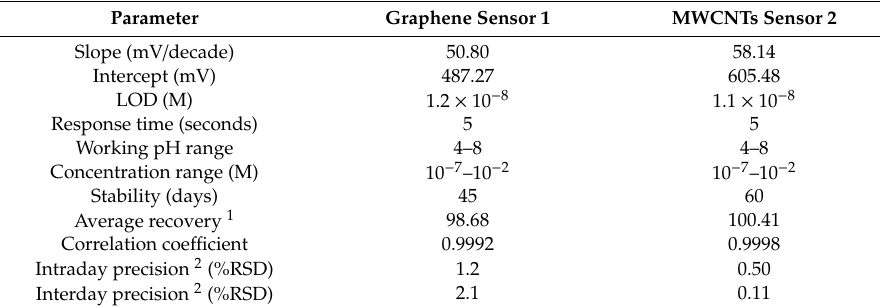
Table 1. General electrochemical characteristics of the proposed